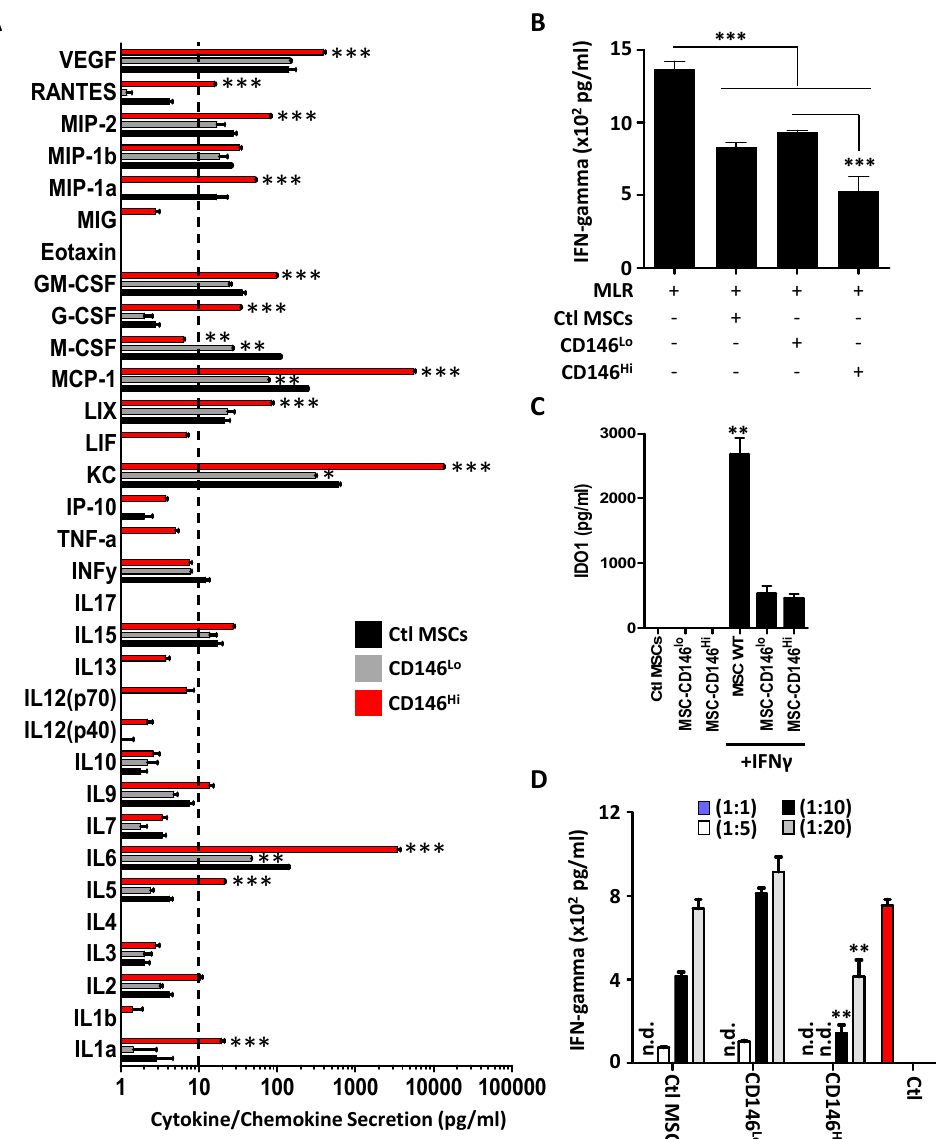
Figure 2. Assessment of the inhibitory properties of MSCs on activated T cells. ( A ) Luminex analysis of various cytokines and chemokines in the conditioned media derived from the ctl MSC population (black), CD146 lo MSC (grey) or CD146 hi MSC (red). For this experiment, n = 6/group with ** p < 0.01 and *** p < 0.001 compared to the ctl MSC population. ( B ) A two-way MLR using a mix of C57BL/6 and Balb/c splenocytes treated with the conditioned media collected from the different MSC populations. ( C ) IDO-1 quantification by ELISA using conditioned media derived from the three MSC populations with or without IFN-gamma pre-treatment. ( D ) A two-way MLR cultured on a layer of MSCs derived from ctl MSCs (parental), CD146 lo MSCs or CD146 hi MSCs at different MSC:T cell ratios. Ctl MLR (shown in red) consists of mixed splenocytes without MSCs. For all panels shown in this figure, n = 5/group with * p < 0.05, ** p < 0.01 and *** p < 0.001.